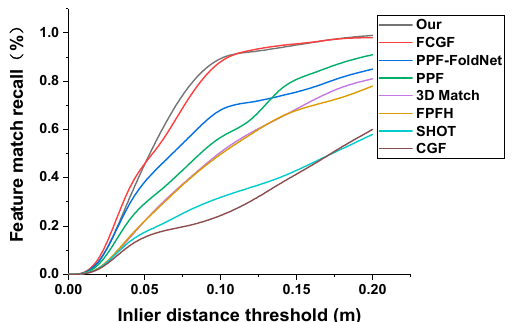
Figure 6. The influence of different internal distance thresholds on the feature match recall.